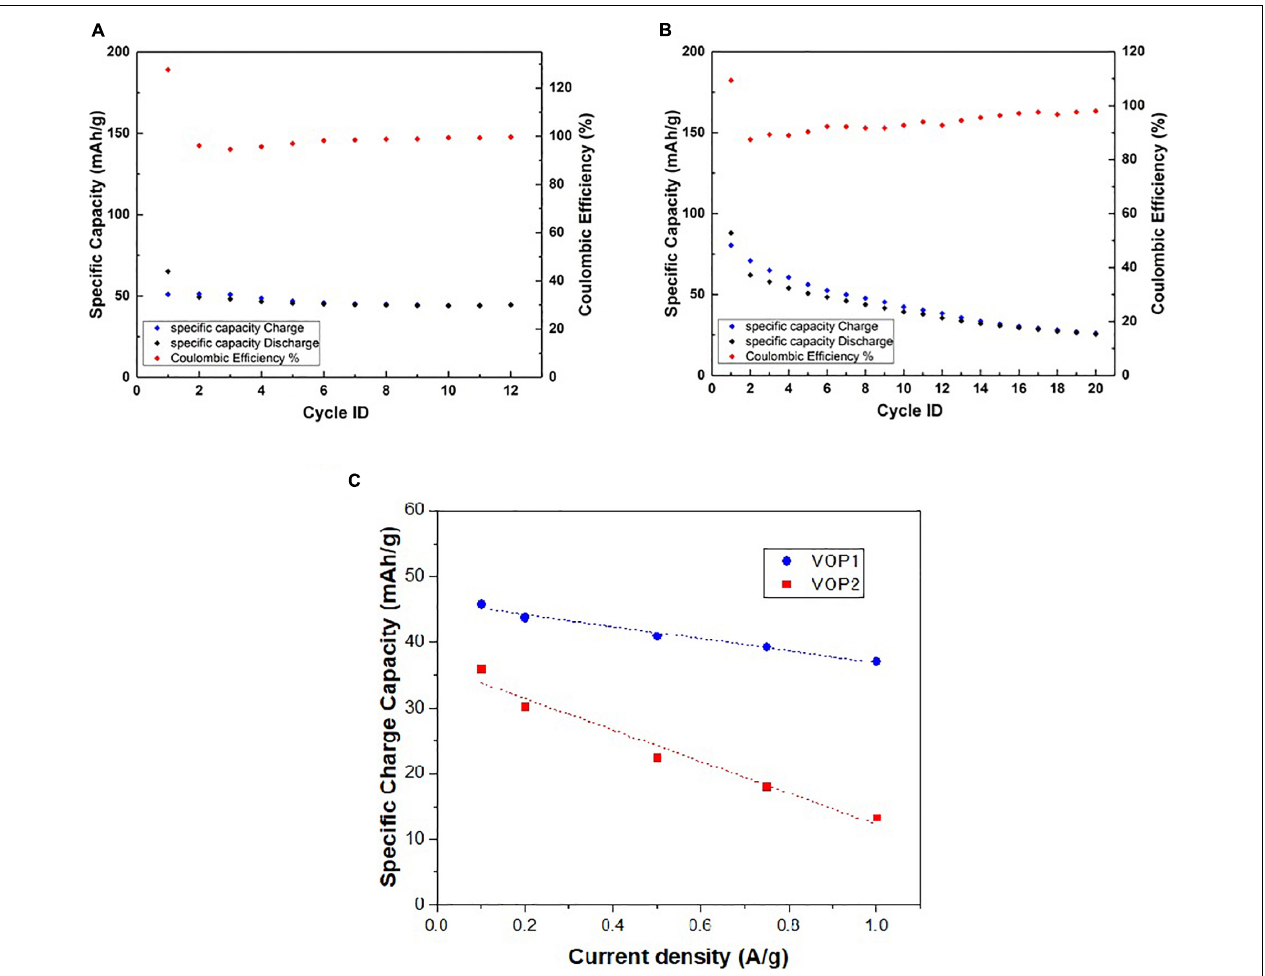
FIGURE 11 | Specific capacity and coulombic efficiency measurements at 160 mA/g of (A) VOP1 and (B) VOP2, (C) rate performance of VOP1 and VOP2 in half-cells using Zn as reference and counter electrodes and 3 M ZnS0 4 .7H 2 O as